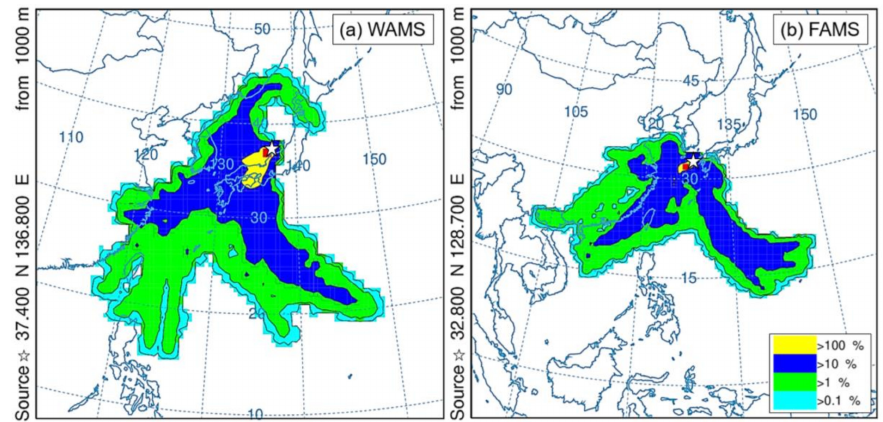
Figure 6. Frequency analysis of backward trajectories at WAMS ( a ) and FAMS ( b ) in the East Asian summer monsoon period (Period 2, 25–29 June 2019). ( (cid:73) ) sampling sites at WAMS and FAMS; ( (cid:4) ) the longest air mass residence